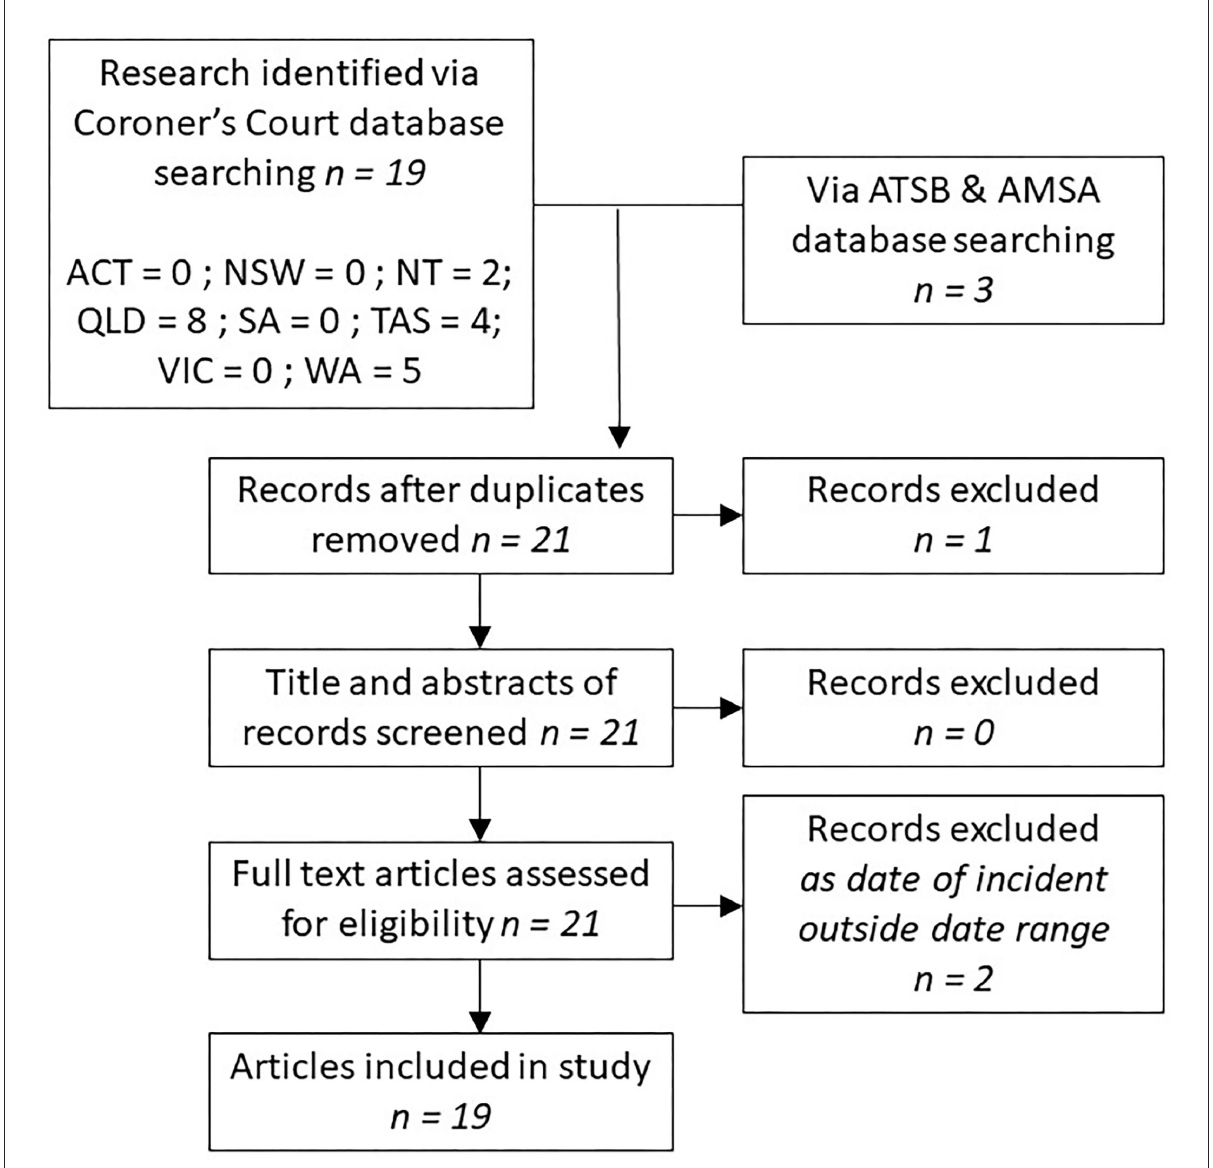
FIGURE2 Phase 2 systematic literature review presented in accordance with PRISMA